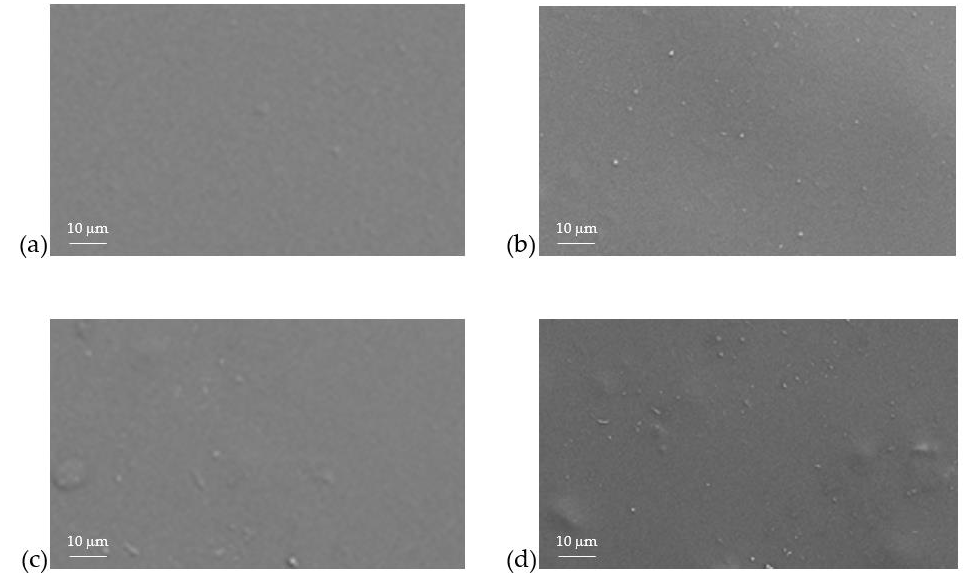
Figure 5. The top view of FESEM images of ( a ) 1% NH 2 KIT-6 / PSF, ( b ) 2% NH 2 KIT-6 / PSF, ( c ) 3% NH 2 KIT-6 / PSF, and ( d ) 4% NH 2 KIT-6 / PSF.